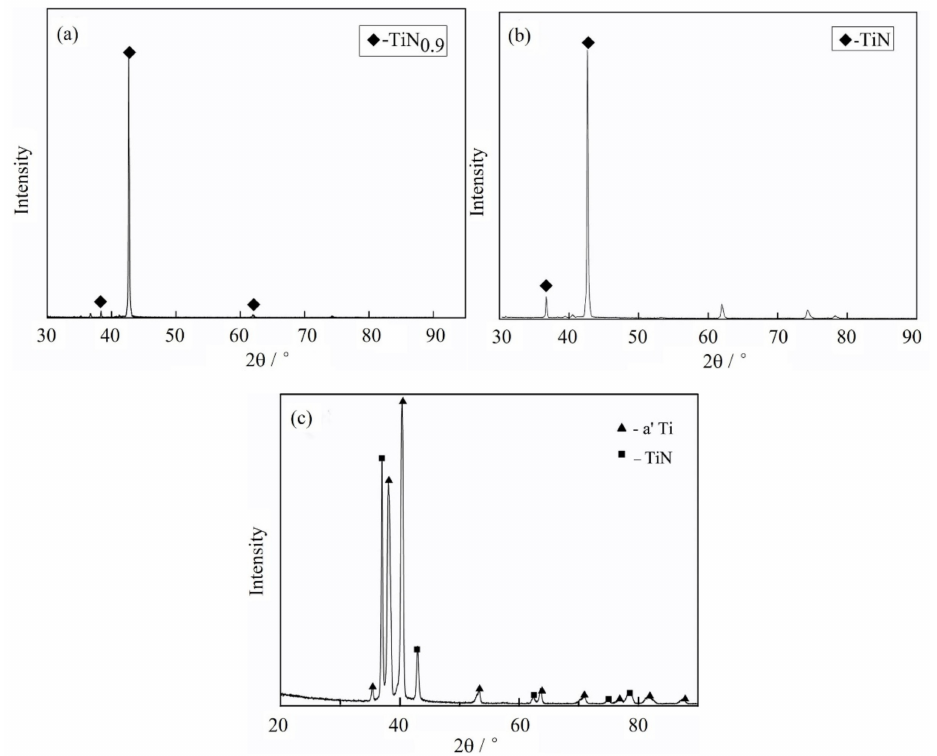
Figure 10. The surface XRD results of the nitrided layers obtained in di ff erent nitrogen content atmospheres; ( a ) pure (100%) nitrogen (100%), ( b ) 80% nitrogen and 20% argon, ( c ) 5% nitrogen and 95%